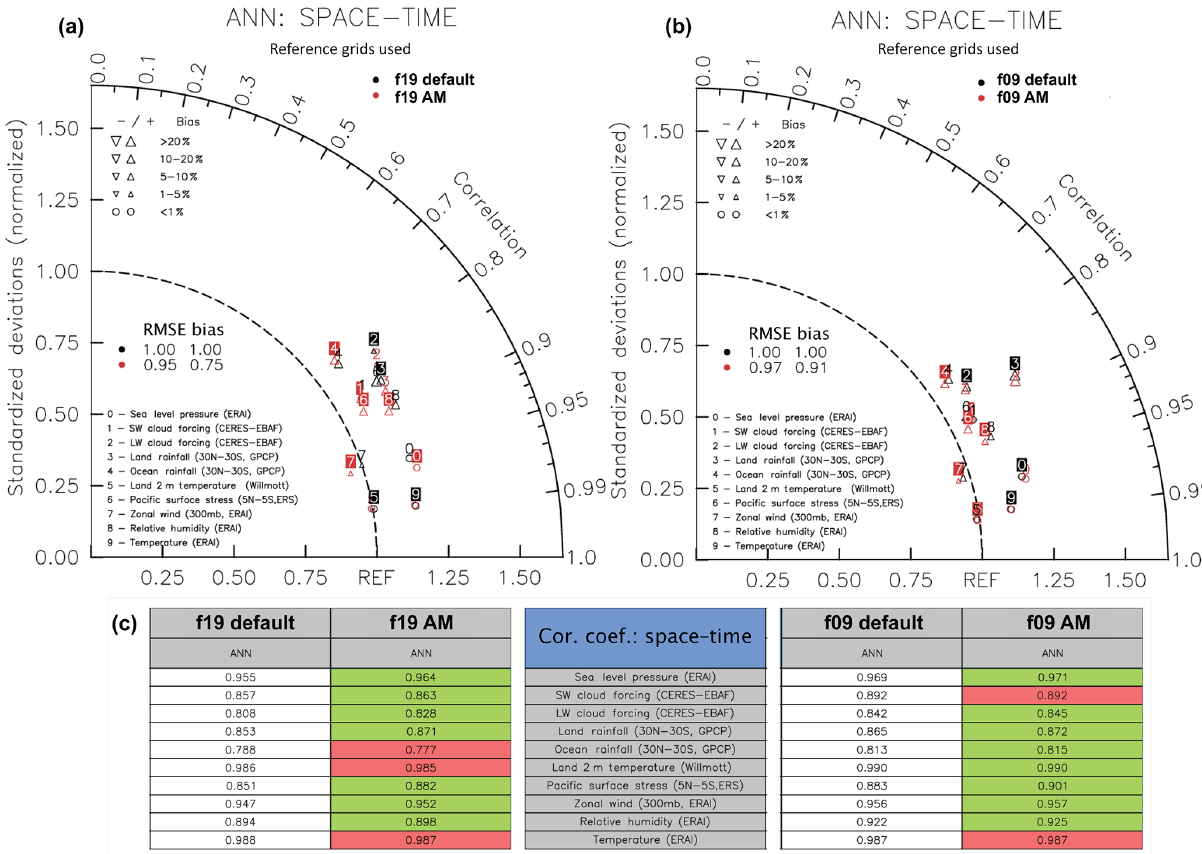
Figure 11. Impact of the AM correction and fixer in F2000 simulations. Panels (a) and (b) show Taylor (2001) diagrams for the validation of the CAM–FV F2000 simulations at f19 (a) and at f09 (b) resolution against observations for a standard set of diagnostic fields, which are listed in the panels. Black symbols represent RMS differences to observations for the control simulations without modifications, and red symbols are for the simulations using both the AM correction and the AM fixer. For the overall RMSE and bias scores, those from the control simulations are used as normalisation. Panel (c) summarises the correlation values between simulated and observed diagnostic fields, as listed in the central table. Green fields mark all instances in which one of the AM-modified simulations represents an improvement over the respective control simulation. These plots were produced with the AMWG diagnostics package developed by the Atmospheric Model Working Group of the University Corporation for Atmospheric Research and the National Center for Atmospheric